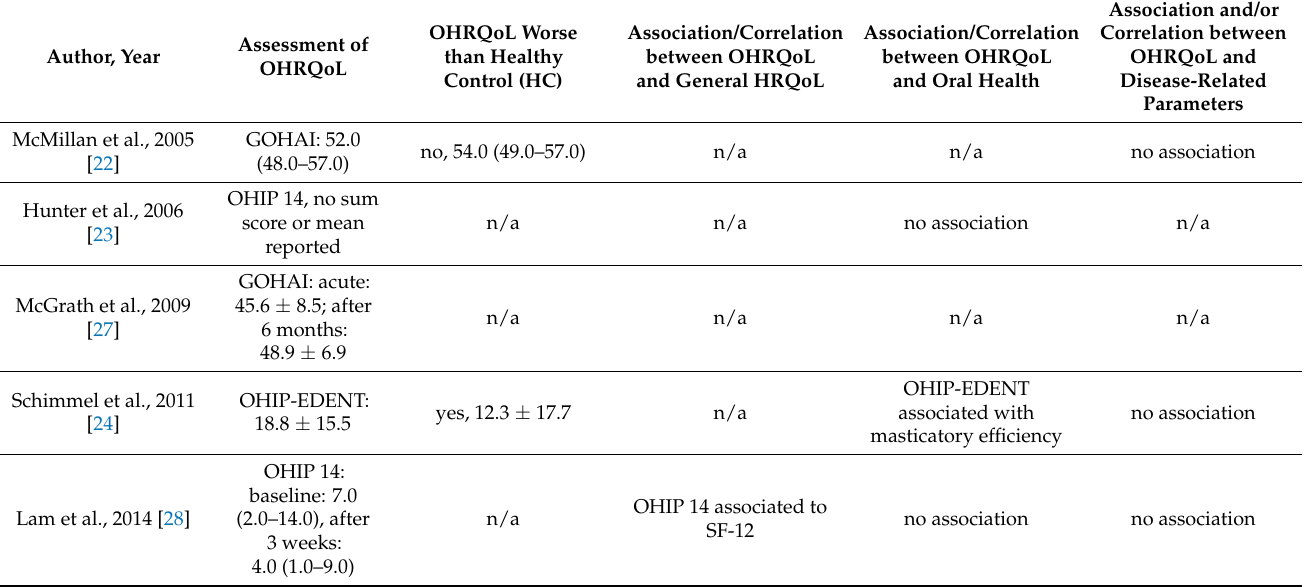
Table 4. Applied assessments for OHRQoL and relevant results for the included